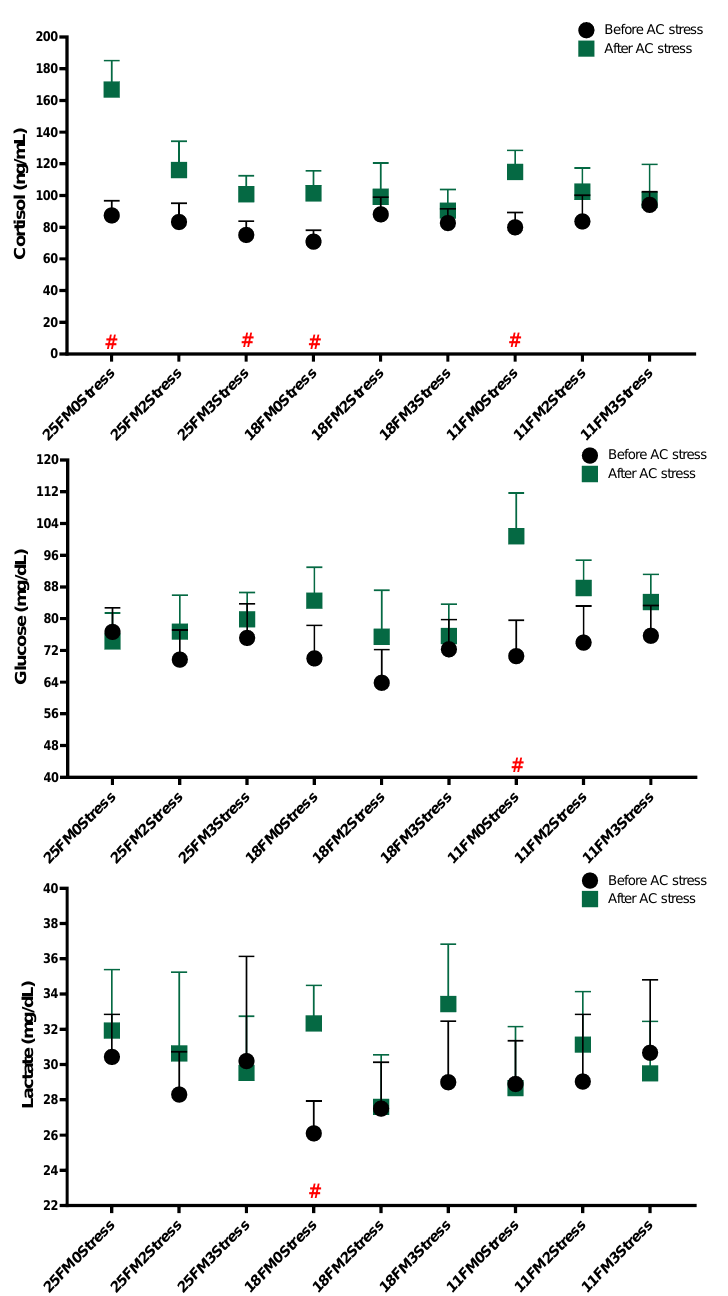
Figure 4. Stress response parameters of oscar fed experimental diets containing different levels of FM and exposed to secluded early mild stress for ten weeks plus data related to after acute confinement stress (AC stress). Values are represented by means and SDM of triplicate samples. Hash (#) with green colour indicates the significant difference in each treatment before and after AC stress according to the independent sample t -test ( p < 0.05).